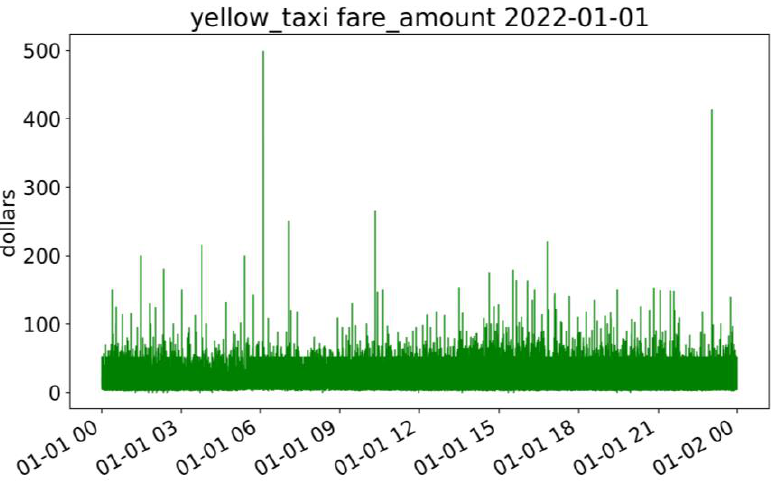
Figure 5. Driver income in New York City on 1 January.